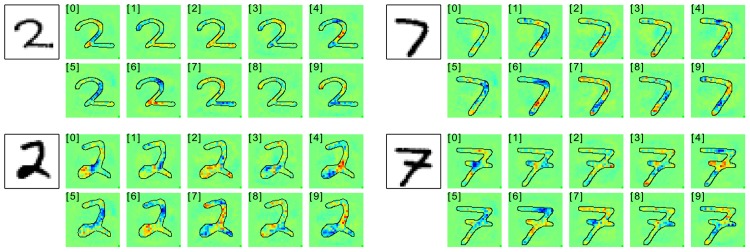
Pixel-wise decompositions for a multilayer neural network trained and tested on MNIST digits, using layer-wise relevance propagation as in Formula (56).Each group shows the decomposition of the prediction for the classifier of a specific digit indicated in parentheses.